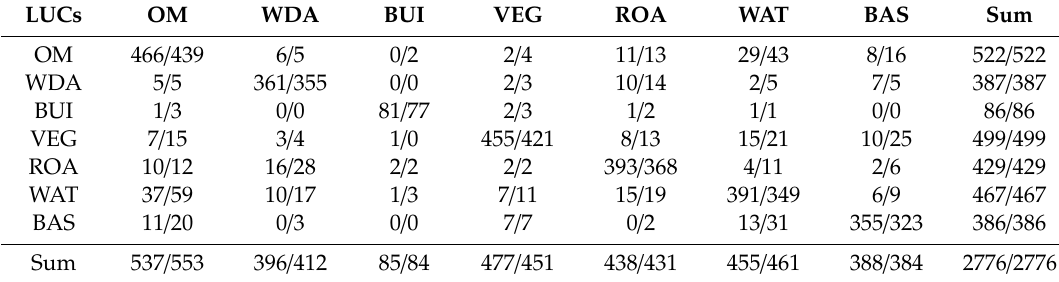
Table 5. Confusion matrix of OMM results of CNN / SVM.